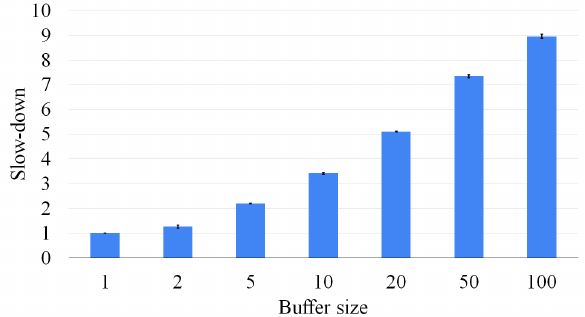
Figure 16. The tree approach: Computation efficiency, i.e., normalized time taken to solve a given set of experiments as a function of the number of intermediate solutions stored (varying from 1 to